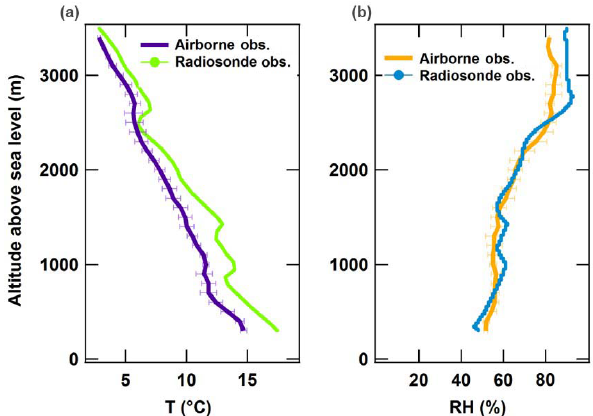
Figure 2. Vertical profiles of temperature ( T , a ) and relative humid- ity (RH, b ) from radiosonde and airborne measurements made on 8 May 2016 over the Xingtai supersite. Horizontal bars represented standard